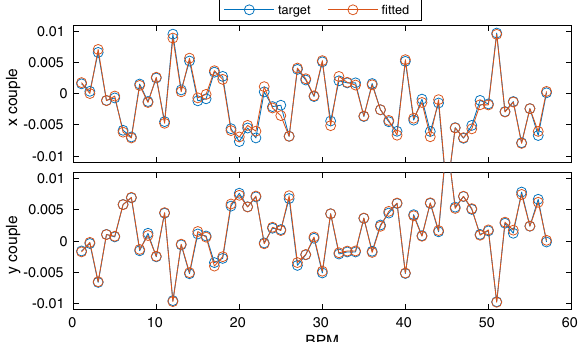
FIG. 7. Comparison of fitted BPM coupling coefficients and the target values. Note that the target values are deliberately made ¼ − c with c . y x